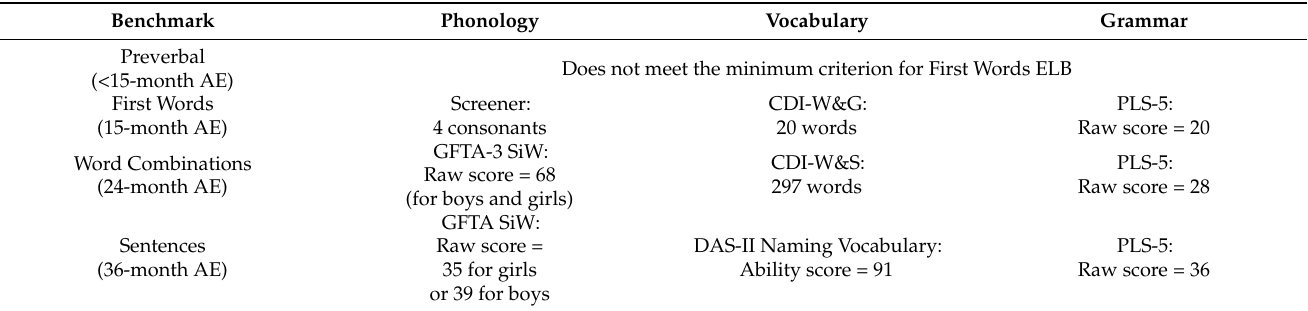
Table 1. Expressive Language Benchmarks Minimum Criteria as a Function of Language Domain. Benchmark